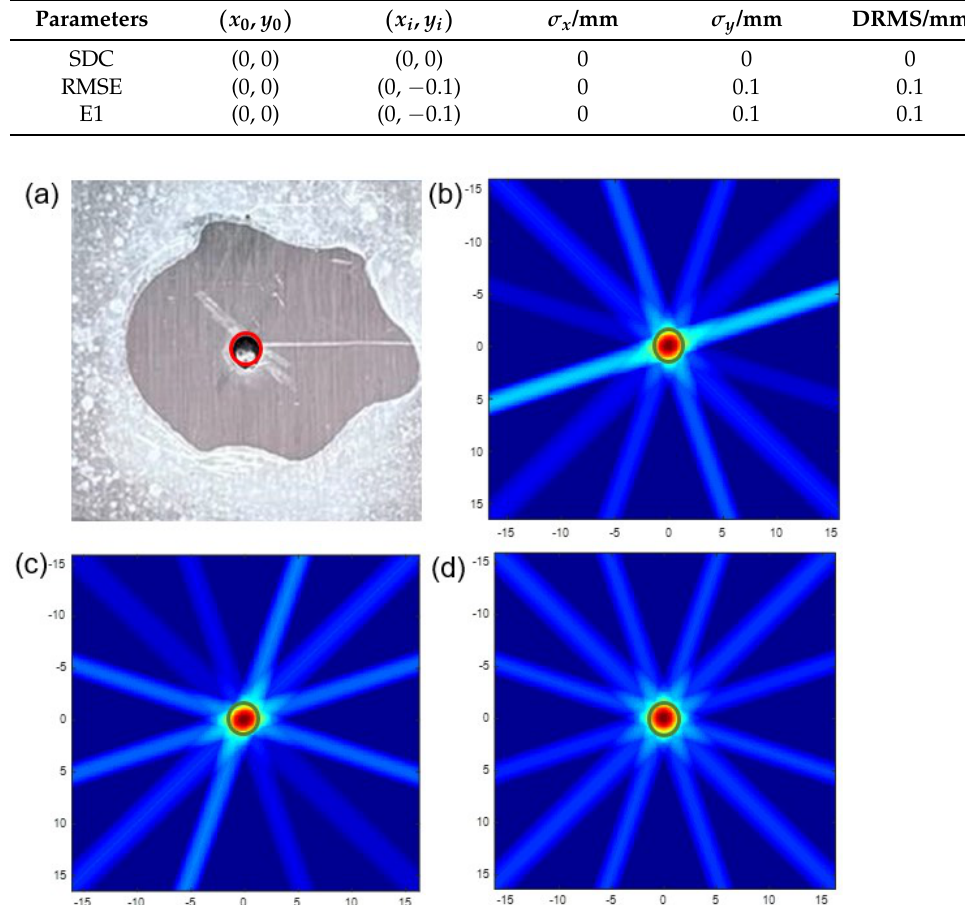
Figure 11. Enlarged views of real defect and simulated pitting corrosion ( a ) real defect. ( b ) SDC. ( c ) RMSE. ( d ) E